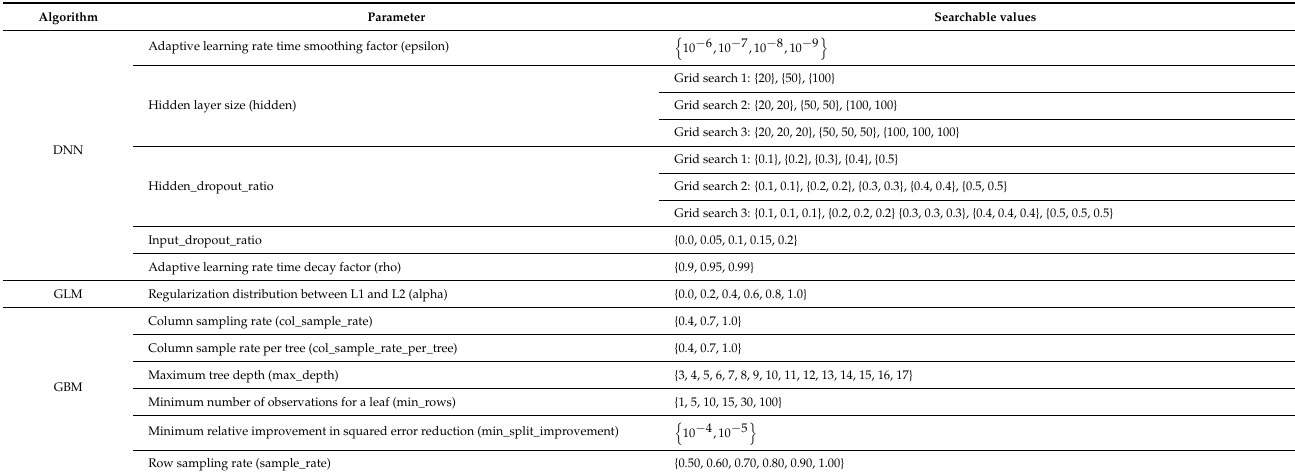
Table 4. The hyperparameter search space for GS optimization for AutoML-based slope stability classification.